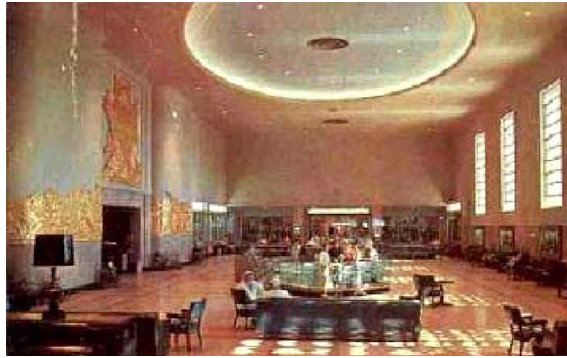
Figure 5. The Greater Fort Worth International Airport Deco Terminal (1953), demolished in